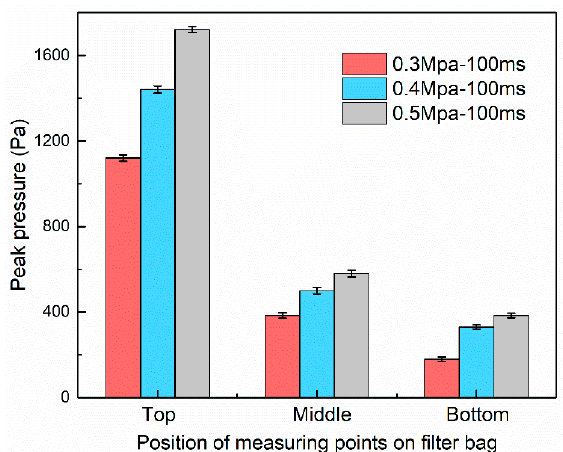
Figure 5. Effect of the pulsing air pressure on peak pressure of filter bag. Figure 5. E ff ect of the pulsing air pressure on peak pressure of filter